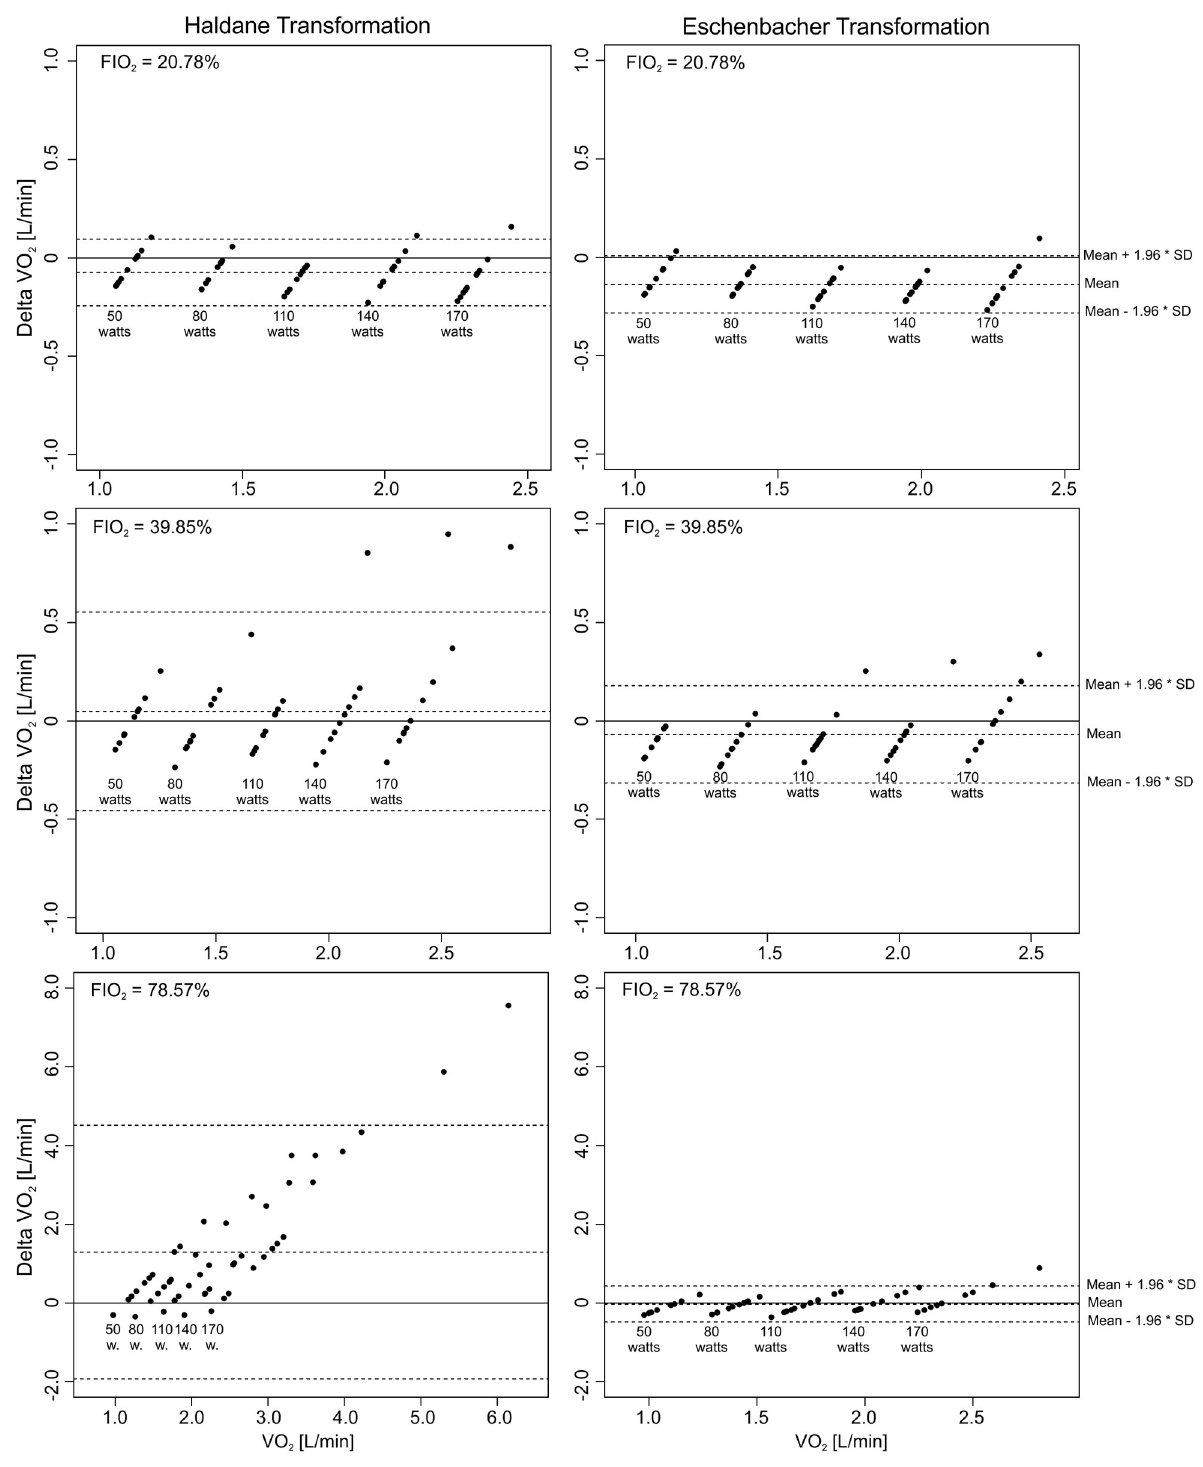
Fig 1. Bland-Altman comparison between HT and ET with the predicted values of Wasserman at each FIO 2 = Level. On the ordinate, the differences between HT vs. Wasserman and ET vs. Wasserman values are shown. On the abscissa, the reached _ VO load-level are shown.